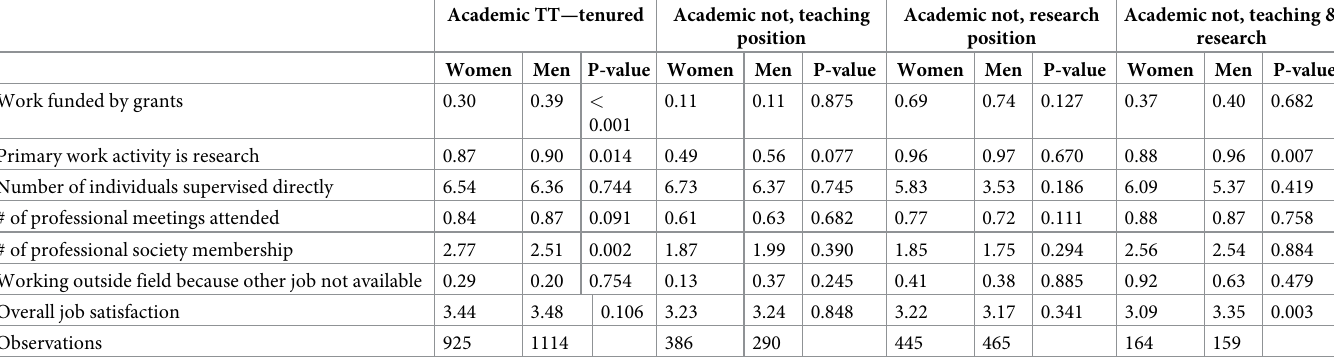
Table 2. Job outcomes and activities by job type and gender. SDR stats measured for observations between 7–9 years